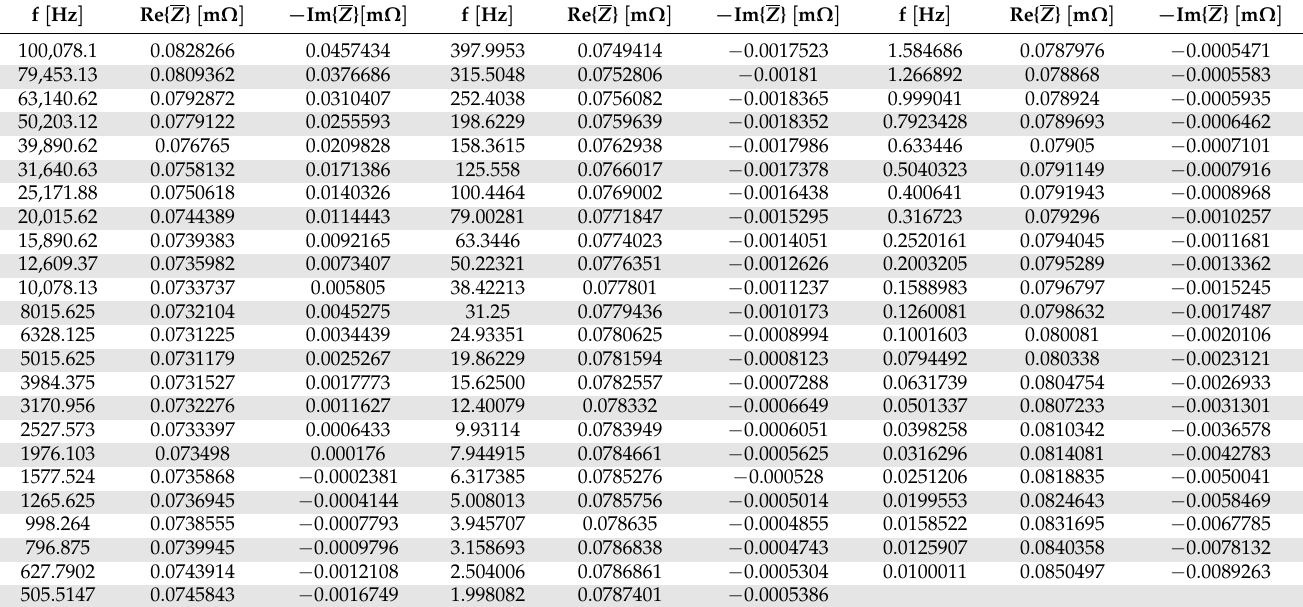
Table A10. EIS data for Murata Sony VTC5A at an SOC of 50%.